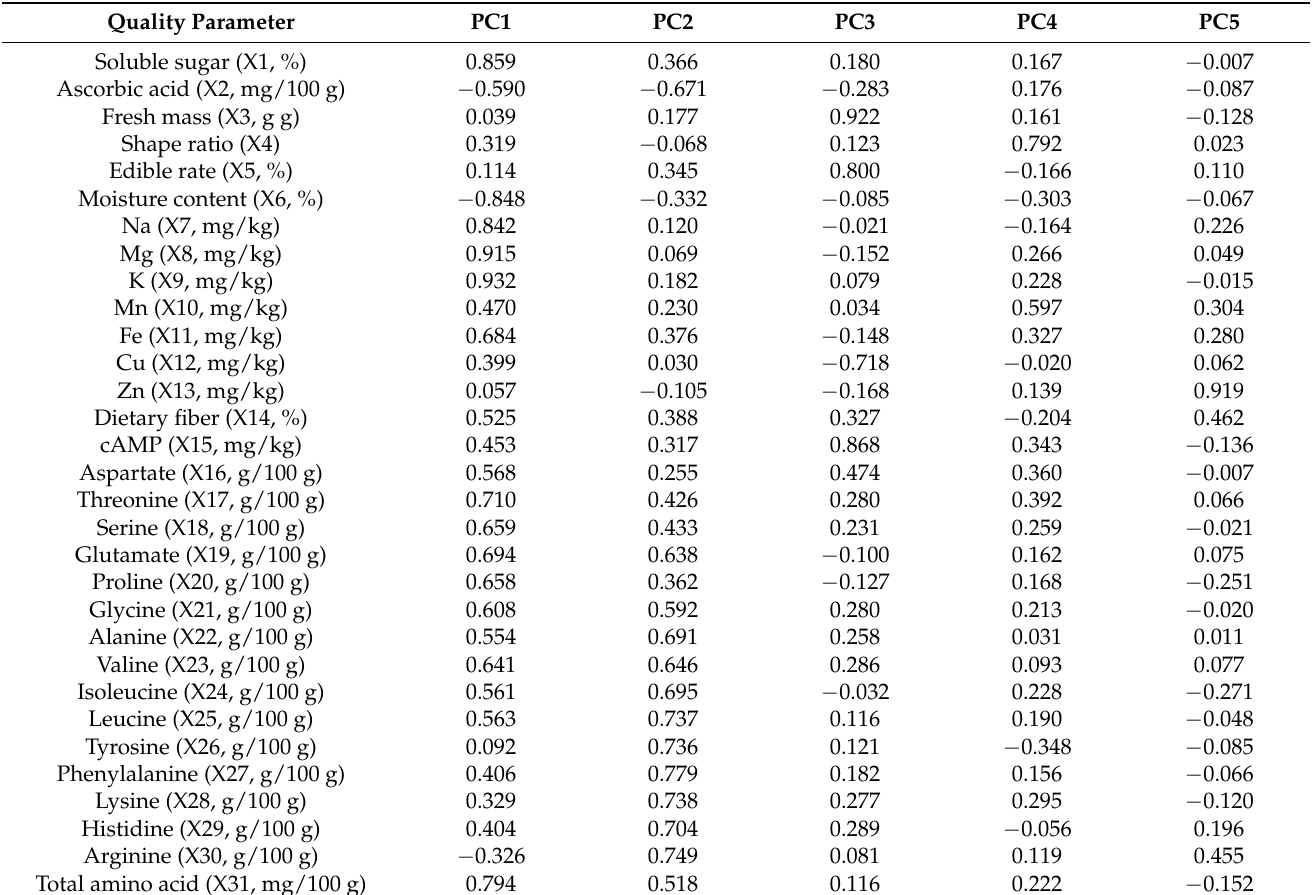
Table 3. Varimax rotated factor loadings of the first five principal components